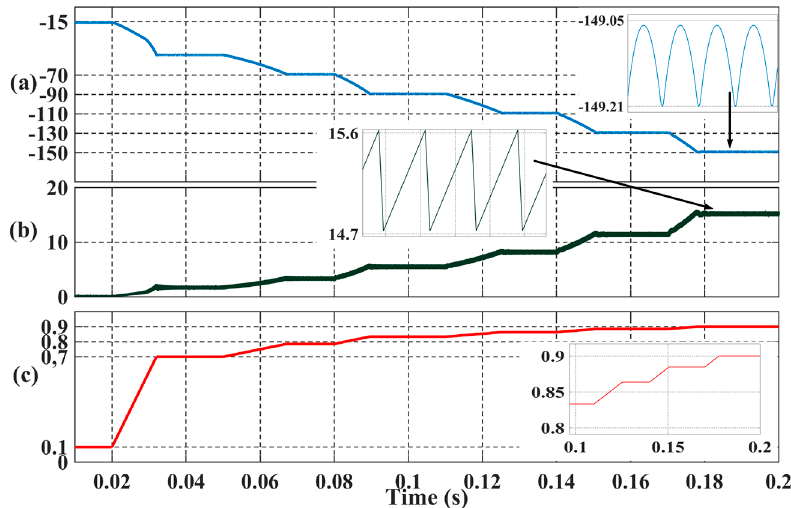
Figure 3. Simulation of modified Ć uk converter. ( a ) Output Voltage (V); ( b ) Input Current (A); ( c ) δ .